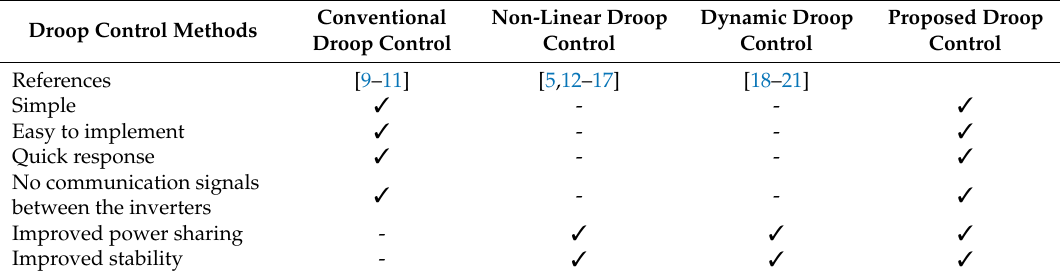
Table 1. The advantages and disadvantages of droop control